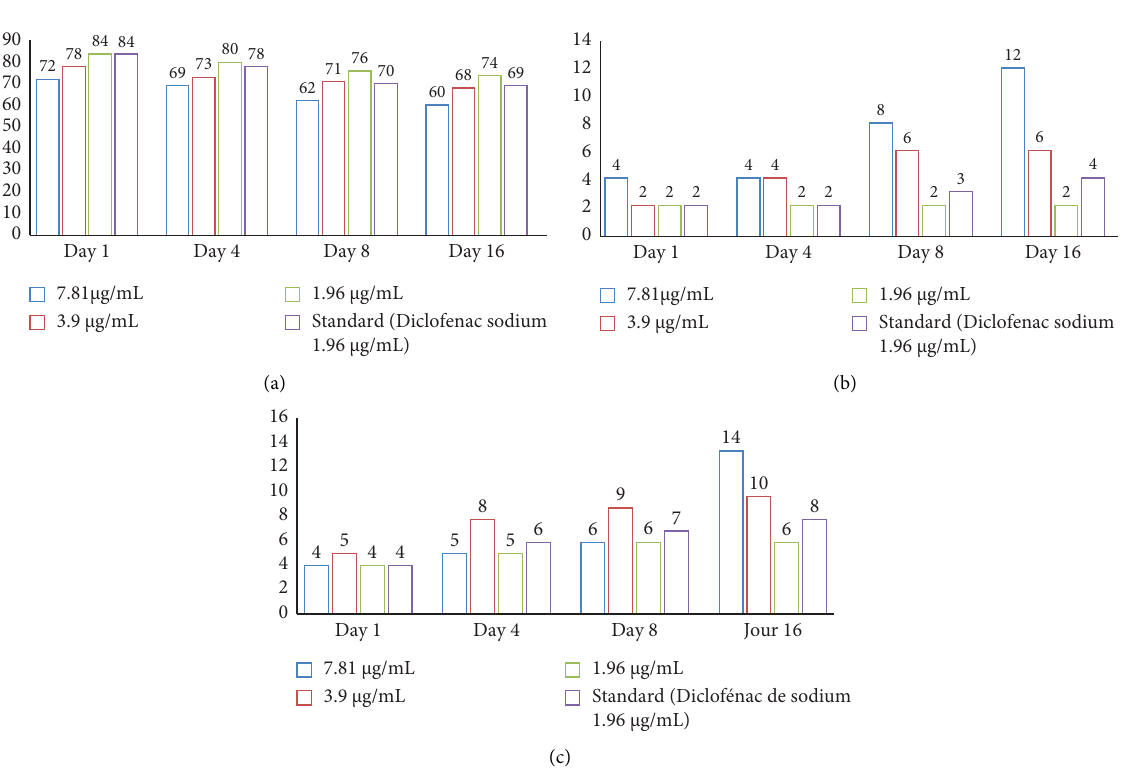
Figure 3: Proportion of erythrocyte cells in the blood of tadpoles exposed to Antrocaryon klaineanum for 16days. (a) Mature erythrocytes; (b) erythroblasts; (c) degenerating